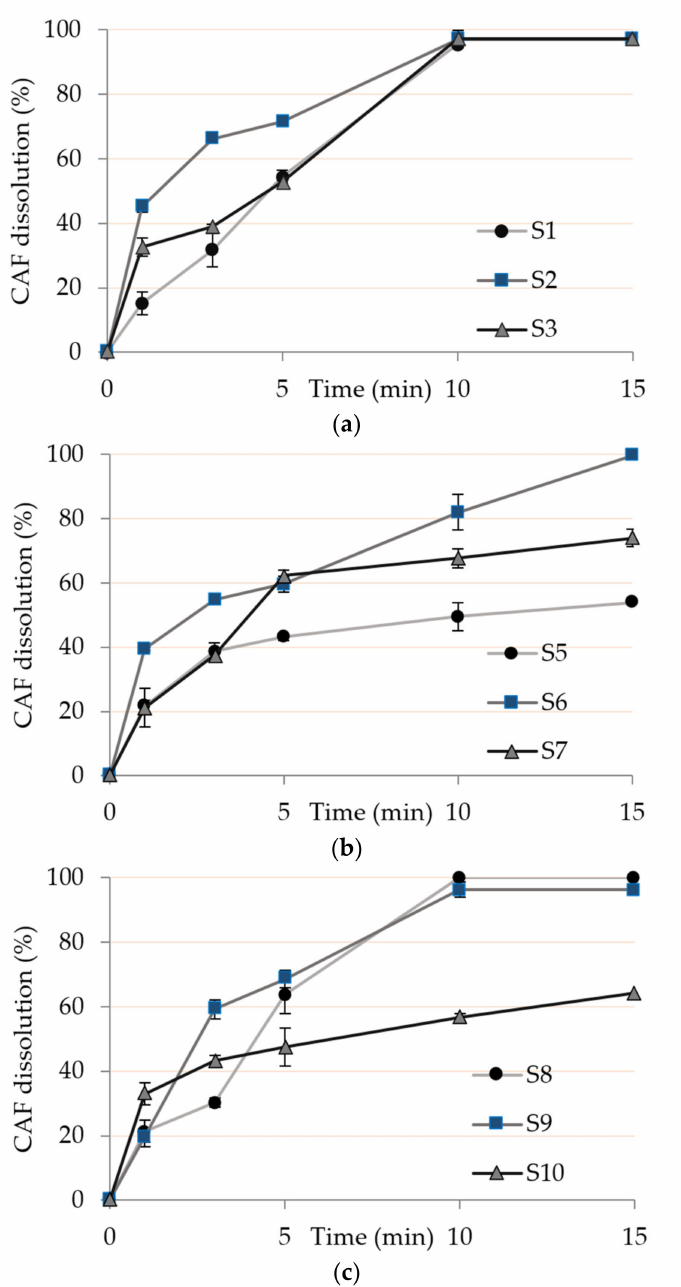
Figure 4. Dissolution profiles of caffeine (CAF) from the investigated samples: ( a ) subset I; ( b ) subset II and ( c ) subset